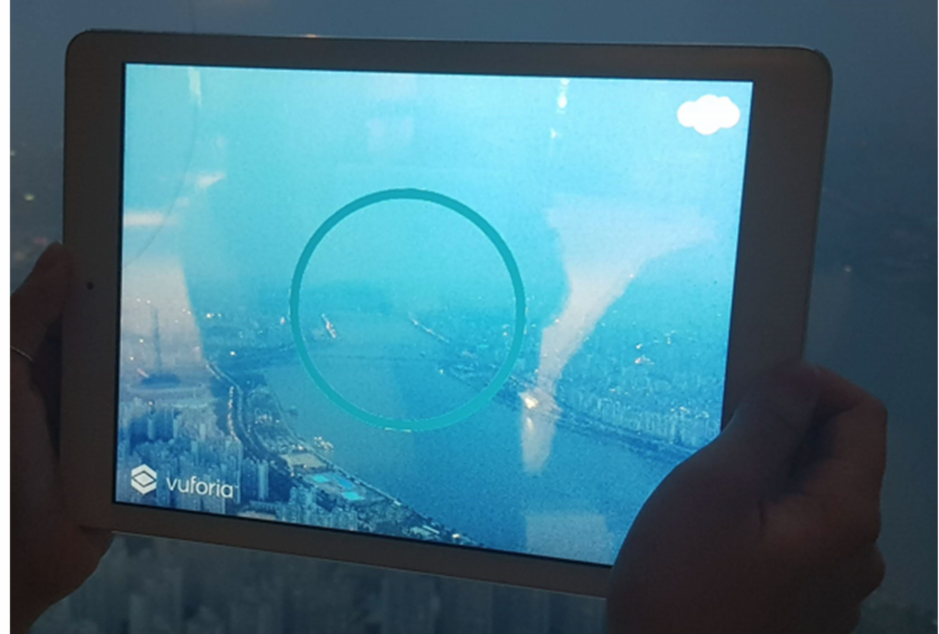
Figure 7. After successfully completing Mission 1, Mission 2 can only be completed after finding the actual place in the observation space; then, detailed information about the location is provided to the user. The user can see the circle when they are successful.